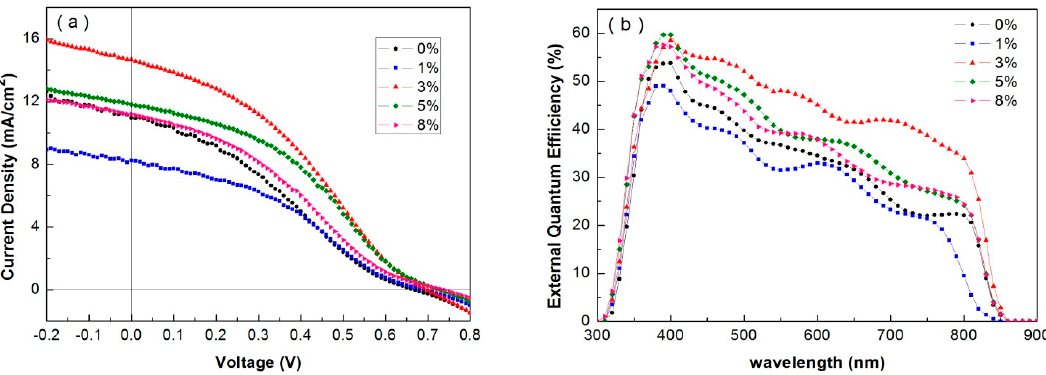
Table 2. Summarized performances of CdTe–TiO 2 heterojunction solar cells with dopant concentration.